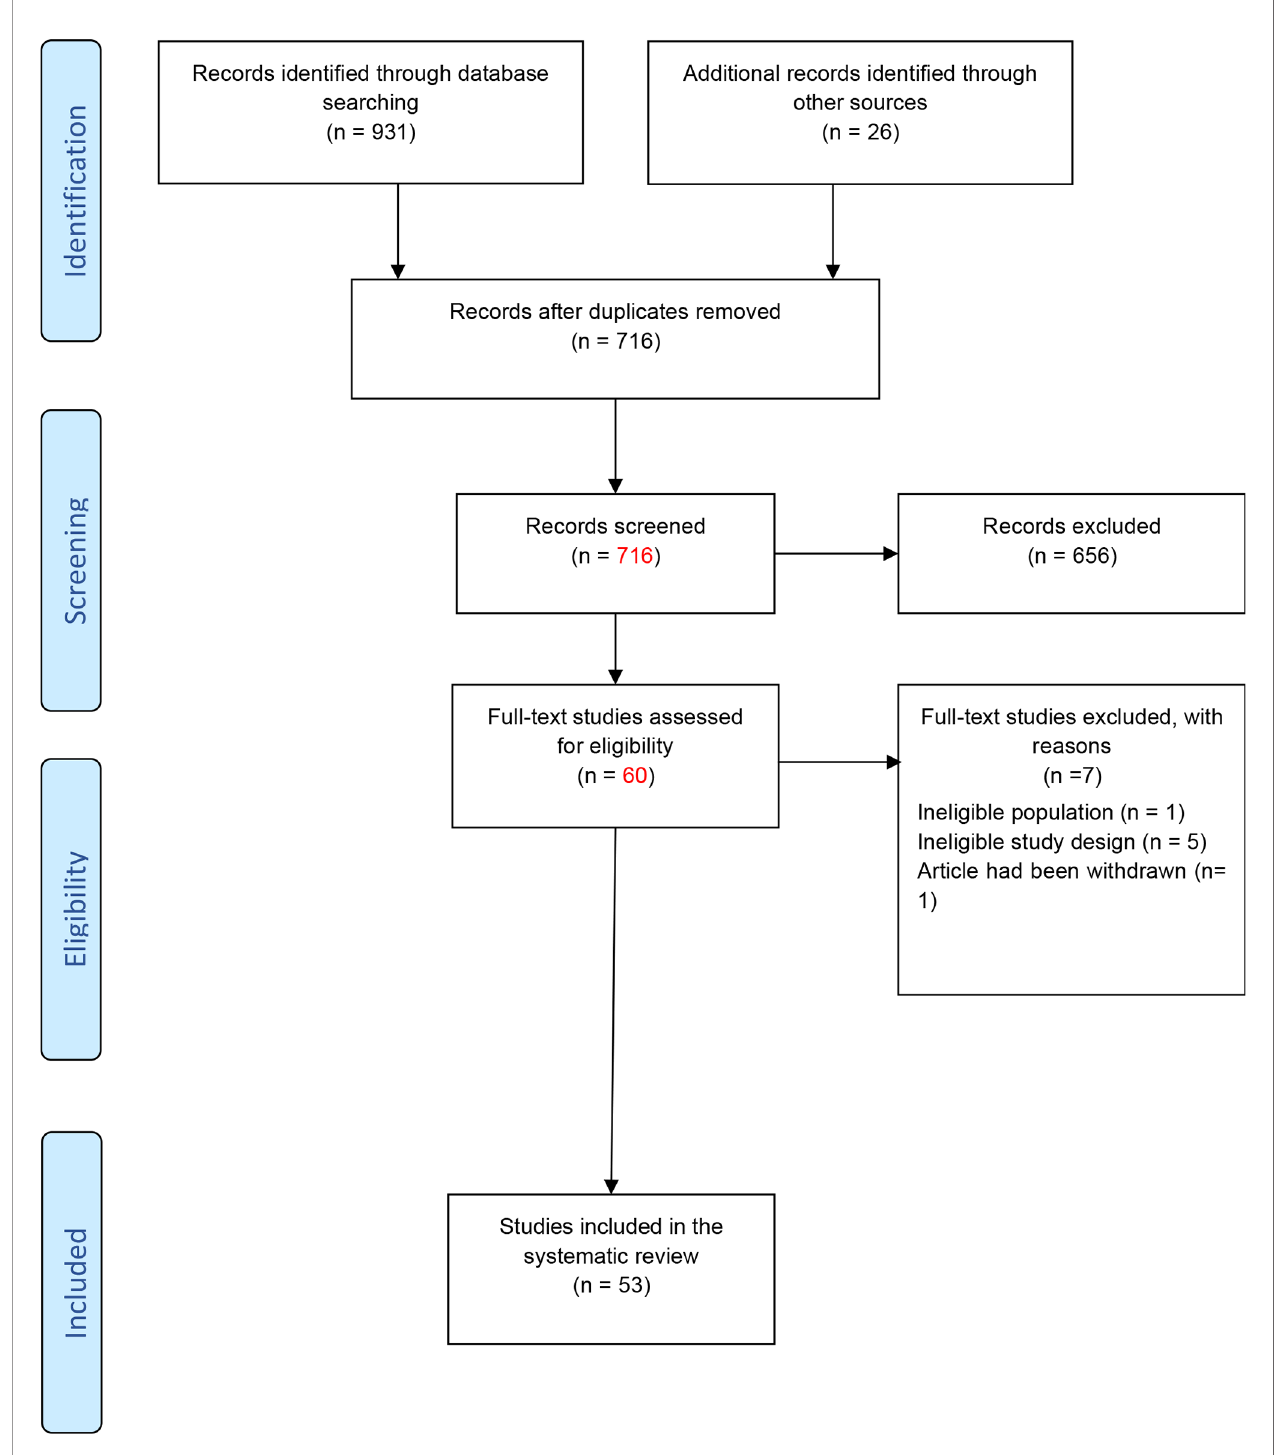
FIGURE 1 | Flowchart of the study